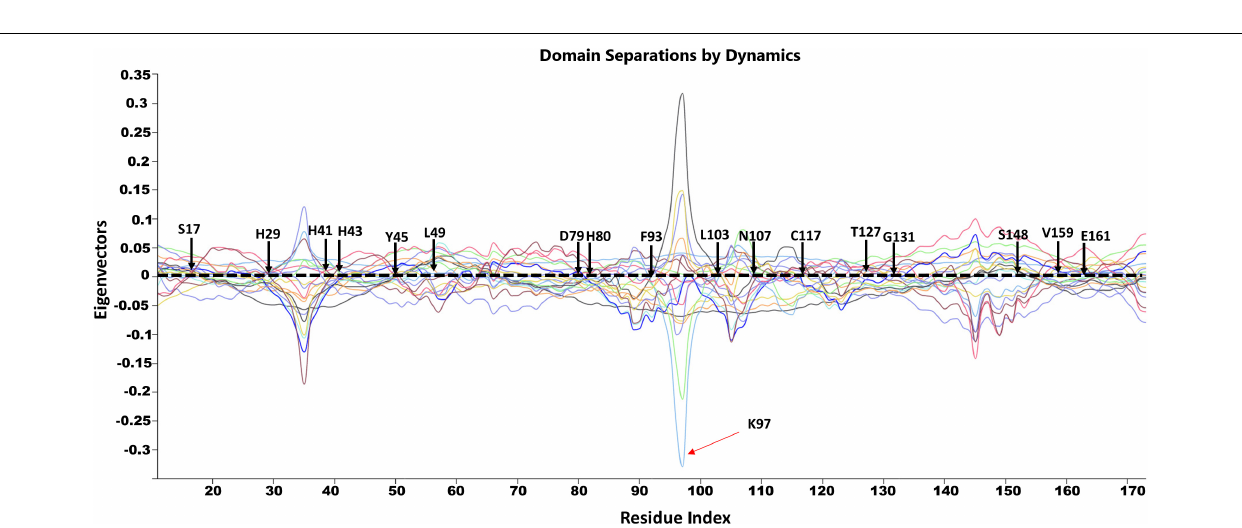
FIGURE 11 | GNM based identification of global hinge sites over the low-frequency modes. Hinge residues are located at the crossover line where the eigenvectors’ values are equal to zero. Residues surrounding the hinge residues showed significant fluctuation in the positive and negative direction of motion. The identified hinge residues include the active site residues, H29, H41 and H43; the catalytically important residues, H80, T127 and E161; and the active site neighboring residues, Y45, L49, D89, F93, L103, N107, C117, S148, V159 which are illustrated by